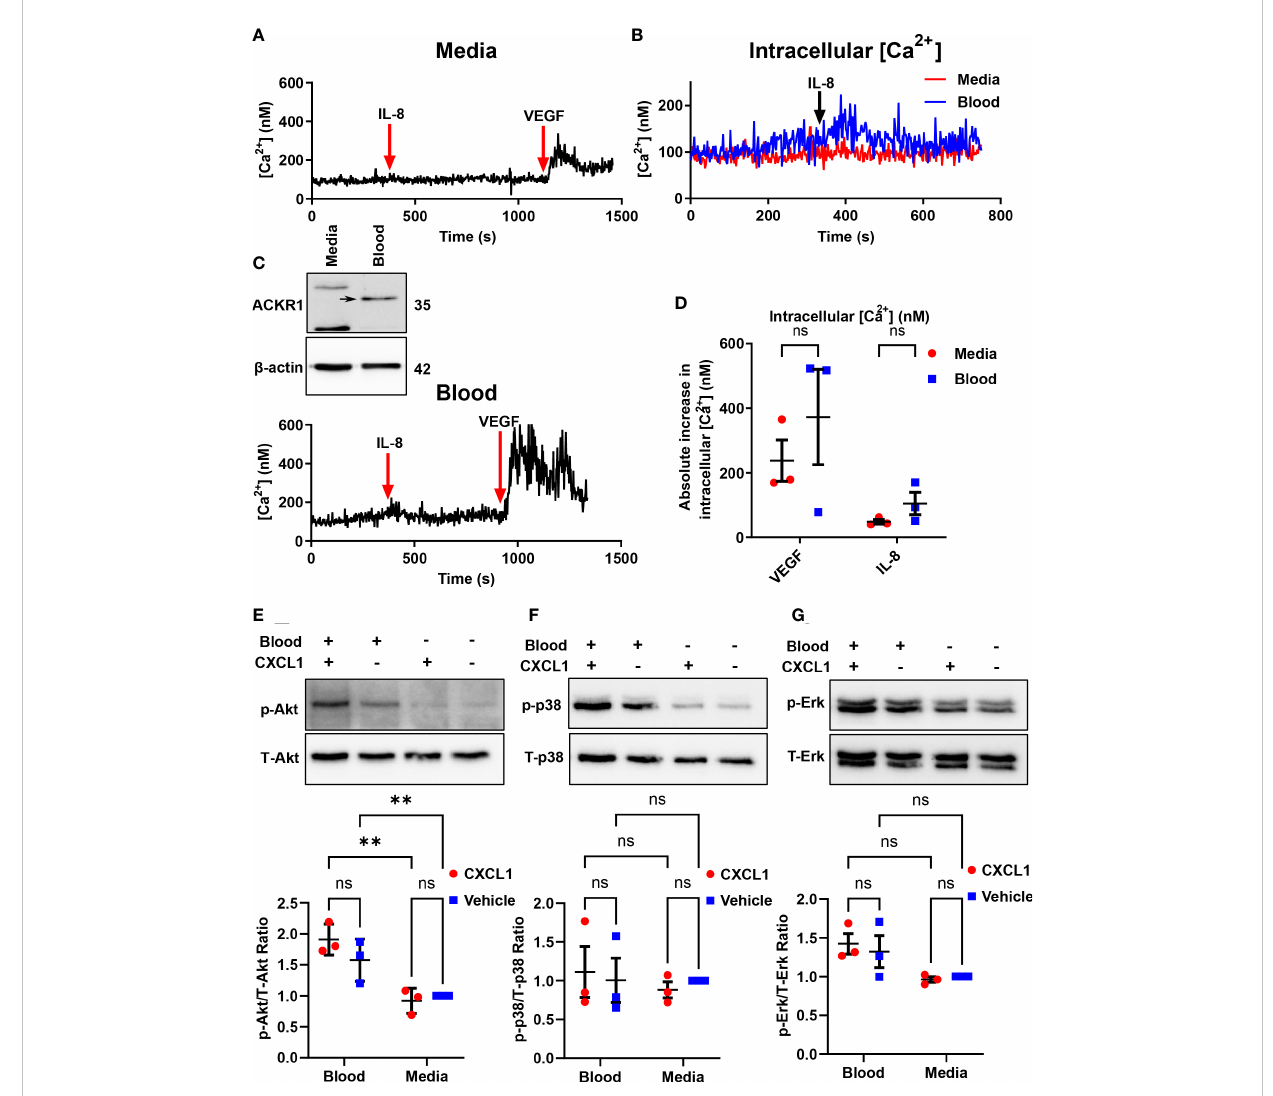
FIGURE 8 Endothelial ACKR1 does not signal upon cytokine stimulation. HPMECs were incubated with blood for 24 hours followed by Fura2-AM loading for calcium measurements. (A, C) are representative measurements of intracellular Ca 2+ concentration in cells treated with IL-8 (100 ng/ml) for 10 minutes followed by VEGF (40 ng/ml) as a positive control. Inset in C) con fi rms induction of ACKR1 by blood. (B) A merged graph of (A, C) showing the calcium concentration upon IL-8 treatment. (D) Quanti fi cation of the change in intracellular Ca 2+ concentration upon stimulation with IL-8 or VEGF for each replicate. (E) ACKR1 was induced by blood on HPMECs followed by treatment for 1 hour with CXCL1 (4 ng/ml). Protein levels of phospho-Akt (p-Akt) and total Akt (T-Akt) were detected by immunoblotting. (F) In the same experiment, protein levels of phospho-p38 and total- p38 and (G) phospho-Erk and total-Erk were detected by immunoblotting; ** p<0.01. ns means not signi fi